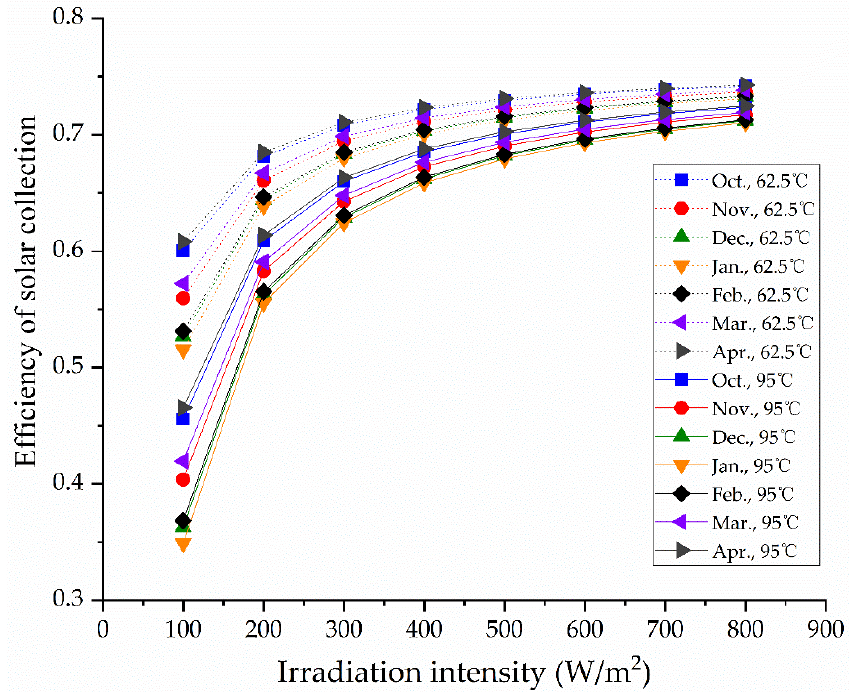
Figure 6. Variation of solar-energy collection efficiency in the heating season.